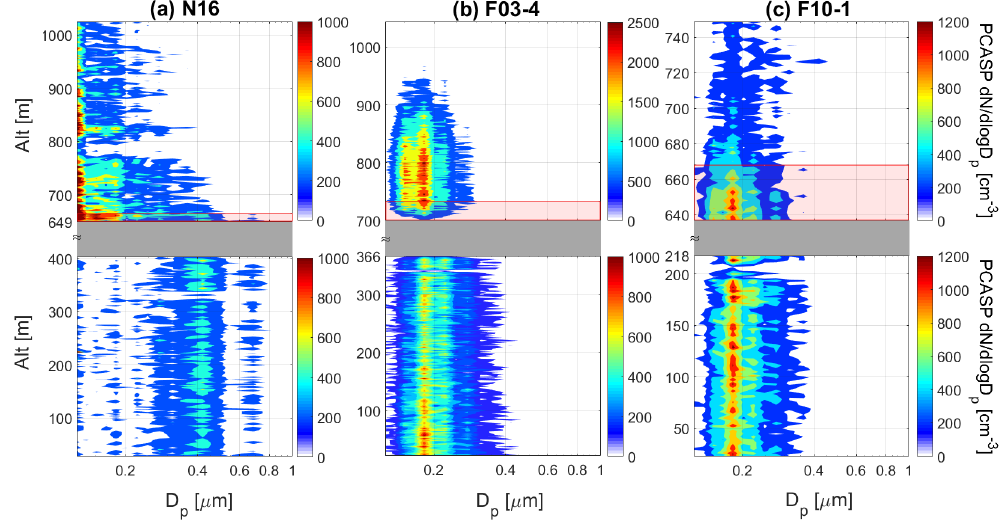
Figure 10. Vertically resolved aerosol size distributions during spiral soundings on (a) N16, (b) F03-4, and (c) F10-1. The EIL and cloud layers are shaded in red and grey,